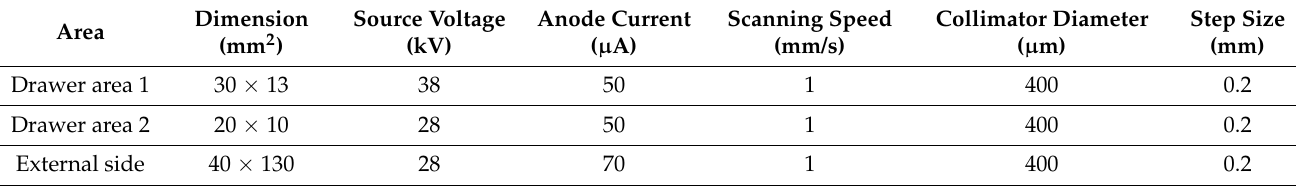
Table 2. Scanning parameters of the areas analysed on the Scrivania con scansia by Pietro Piffetti. Area